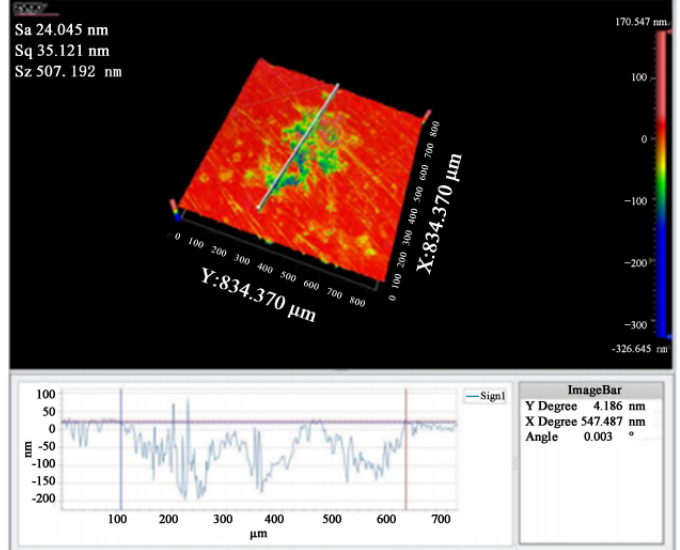
Figure 6. Damaged surface and characterization under shaping laser.